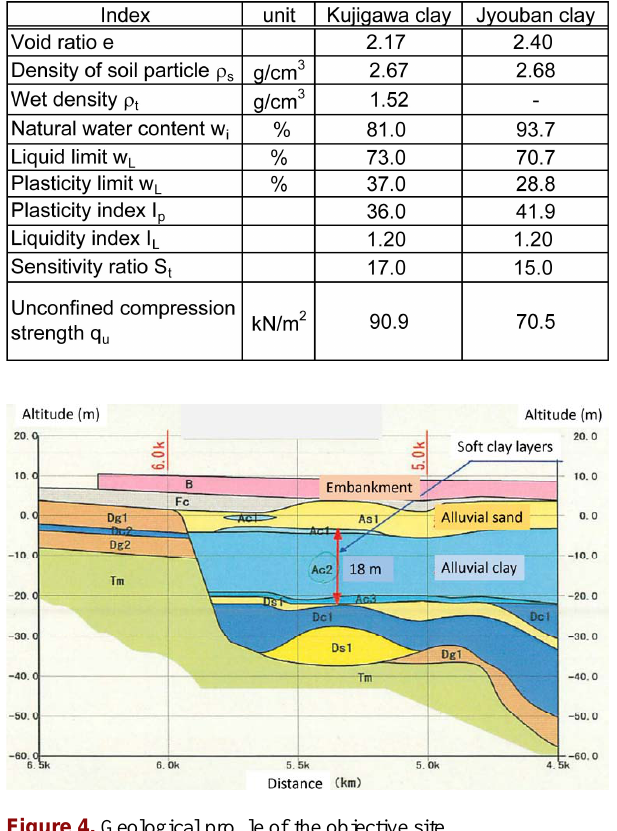
Figure 4. Geological profile of the objective